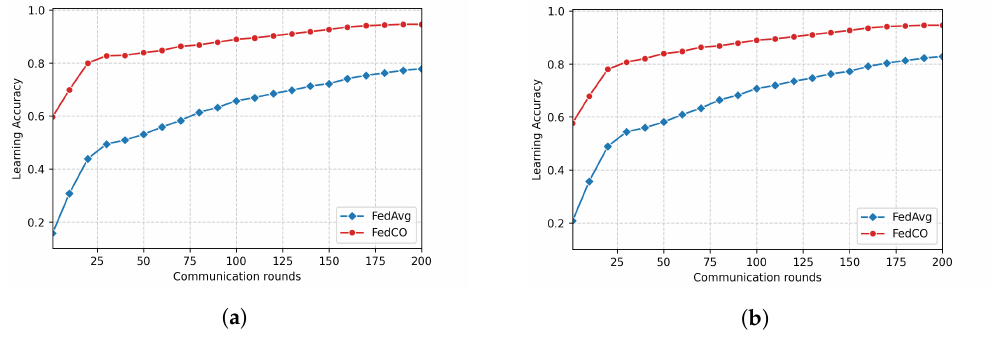
Figure 8. Learning accuracy versus number of communication rounds for FEMNIST data. The top plot presents the results produced in the case of the IID data distribution scenario, while the bottom plot depicts the results generated in the case of the Non-IID data distribution scenario. ( a ) IID; ( b ) Non-IID.